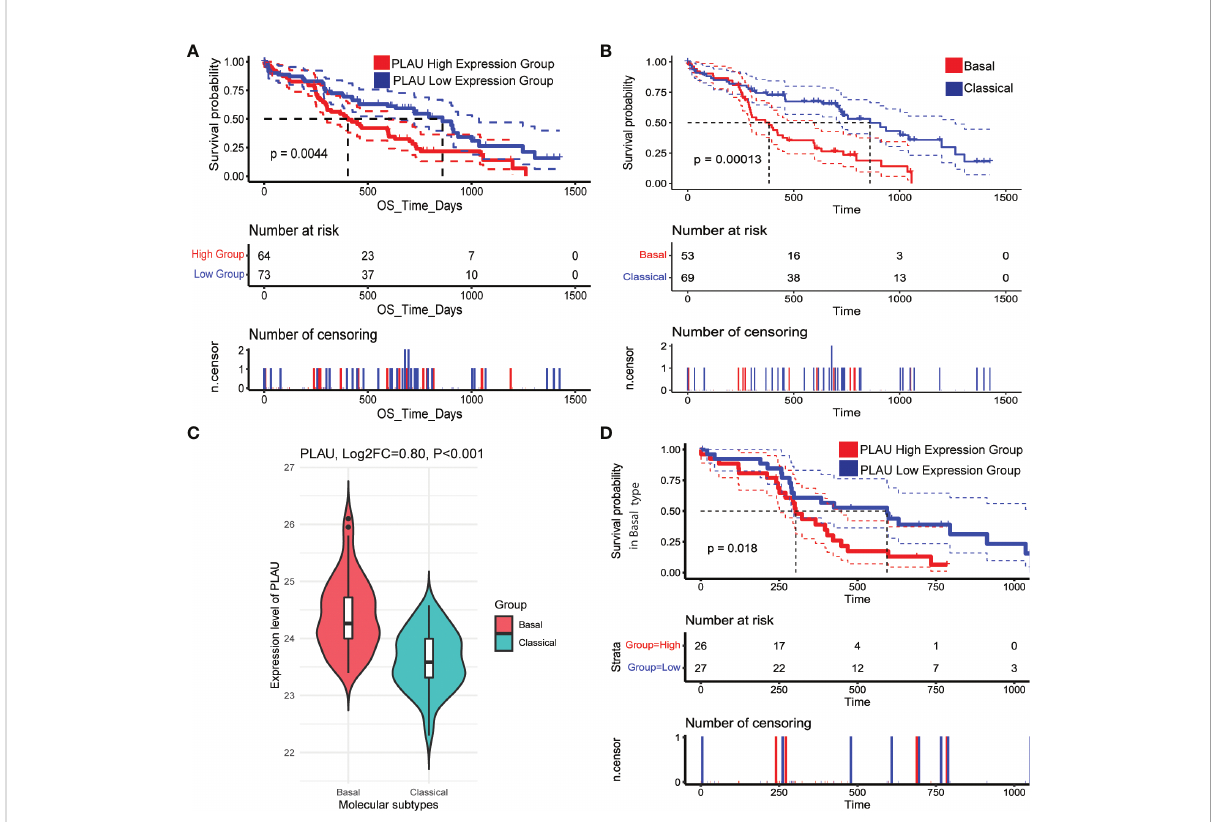
FIGURE 13 PLAU upregulation is associated with the basal type of PDAC. (A) In the CPTAC-PDAC cohort, (A, B) Kaplan-Meier survival curves show that increased PLAU protein expression is associated with poor prognosis (log-rank test, P=0044), and the basal subtype of PDAC is associated with worse survival than the classical subtype. (C) PLAU protein is signi fi cantly upregulated in the basal group than classical subtype (Log2FC=0.80, P<0.001); and (D) within the basal subtype, the clinical outcome in the high PLAU expression group is signi fi cantly worse than the low PLAU expression group (log-rank test,